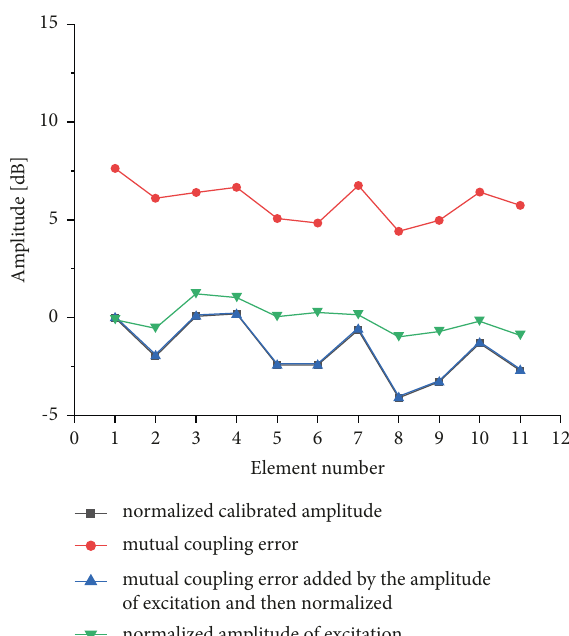
Figure 11: Normalized calibrated amplitude result in the presence of mutual coupling